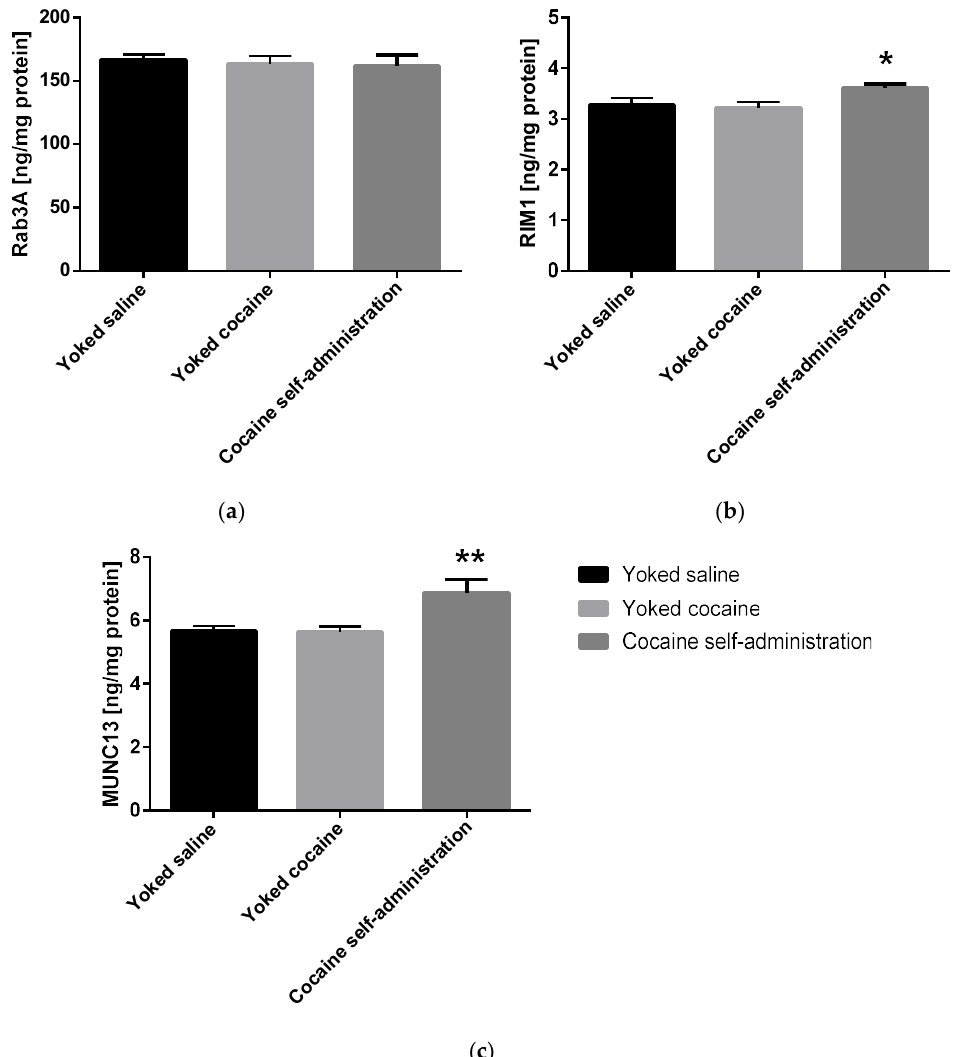
Figure 4. Changes in the concentration of Rab3A, RIM1 and Munc13 in the nucleus accumbens in rats following cocaine self-administration. Ras-related protein A (Rab3A), Rab3 interacting molecules 1 (RIM1) and mammalian uncoordinated protein 13 (Munc13). All data are expressed as mean ± SEM. N = 6 rats/group. * p < 0.05 vs. yoked saline. ( a ), Rab3A [ng/mg protein]; ( b ), RIM1 [ng/mg protein]; ( c ), Munc13 [ng/mg protein].